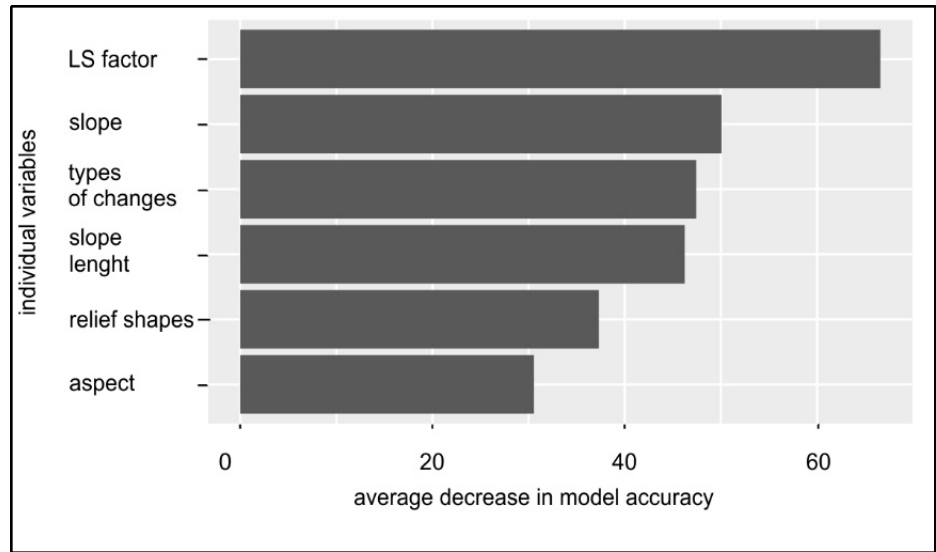
Figure 10. Estimation of the significance of factors.